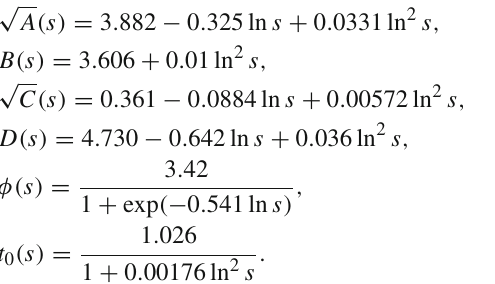
Fig. 2 Comparison between the PB predictions for the differential cross section for pp collisions at the experimental ¯ pp data. The independent fits of the ¯ pp data is also presented for comparison √